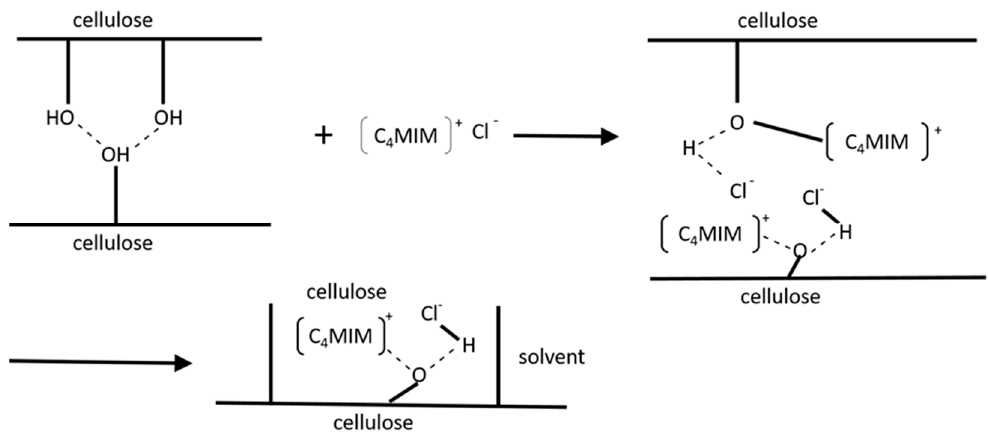
Figure 2. Mechanism of cellulose dissolution in [C 4 MIM]Cl [124].